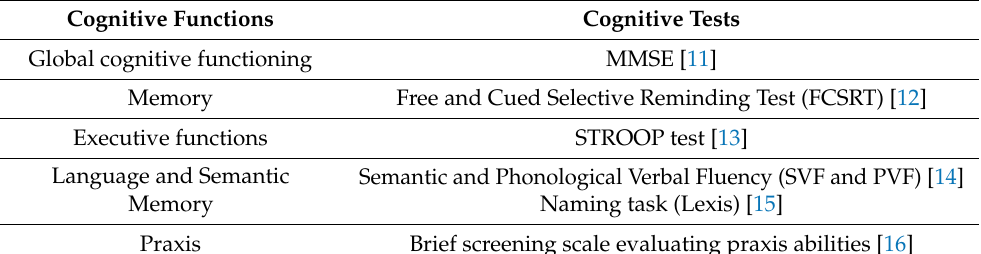
Table 1. Cognitive tests implemented. Cognitive